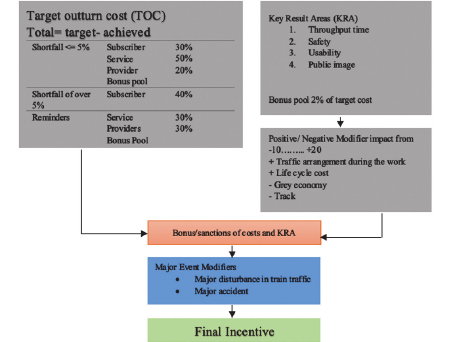
Fig. 3. Performance measurement system TRP (Value for Money, 2018)